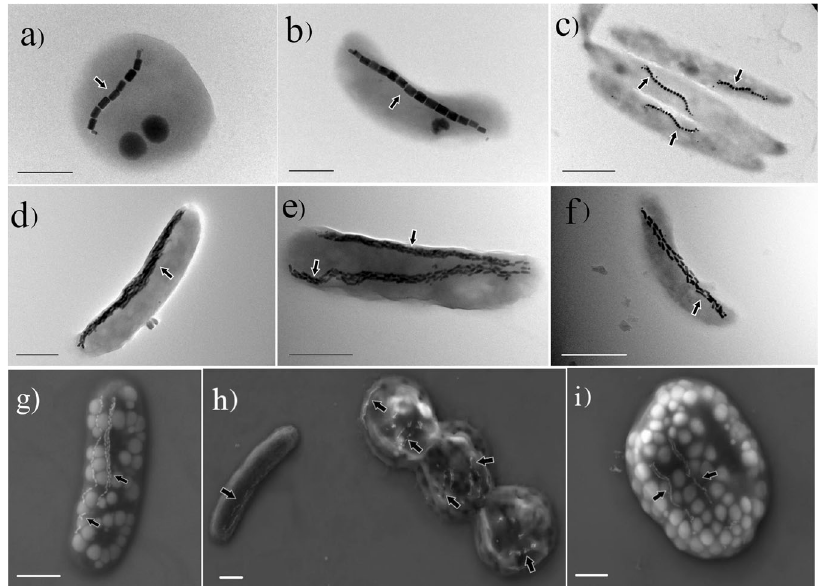
Fig. 1 Electron microscope images of MTB. Transmission electron microscope ( a – f ) and scanning electron microscope ( g – i ) images of various MTB. Black arrows indicate magnetosome chains. Scale bars: a , b = 0.5 μ m, c – i = 1 μ